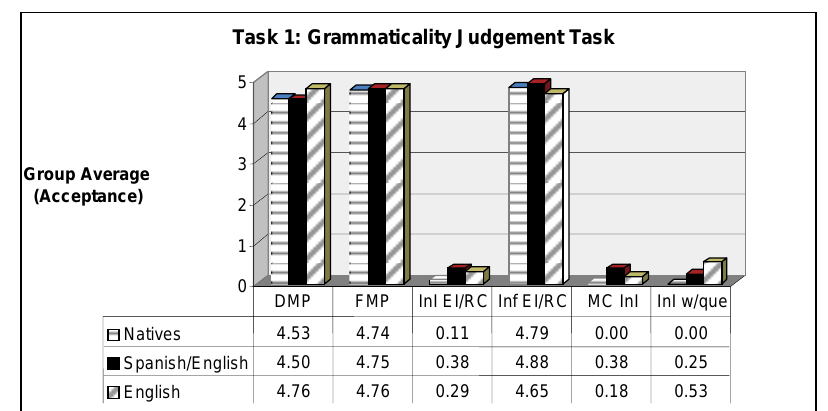
Figure I: Results from Task